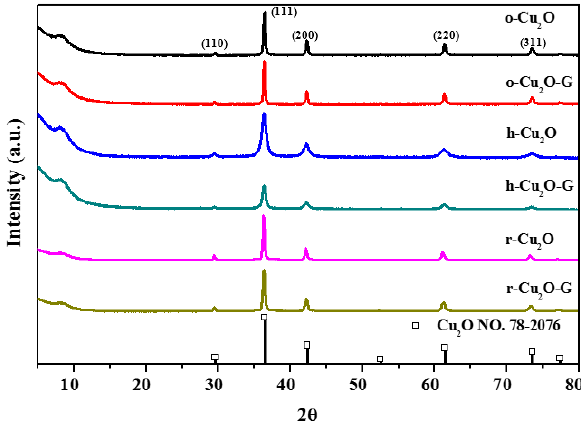
Figure 1. X-ray diffraction (XRD) patterns of different photocatalysts.